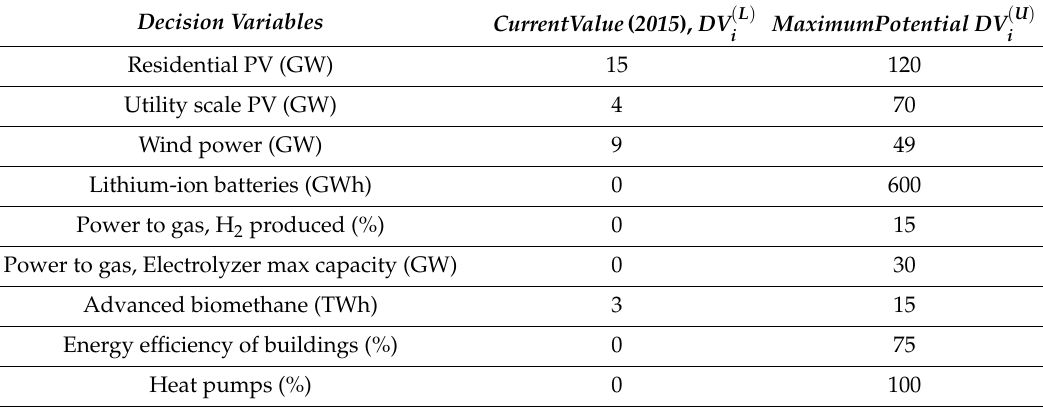
( L ) and upper DV i